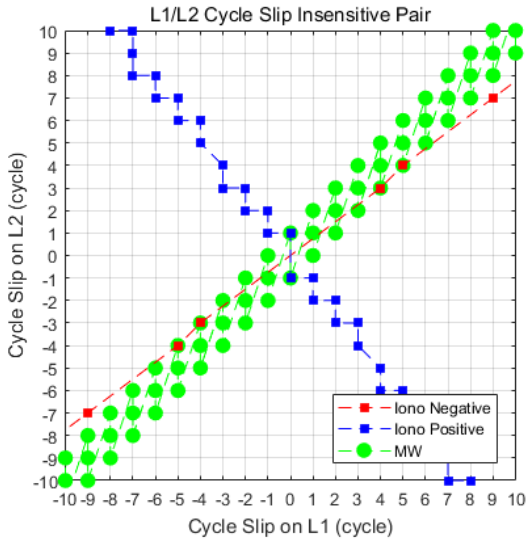
Figure 6. L1/L2 insensitive cycle-slip pairs; the red square points represent the insensitive pairs of the IN combination, the blue square points represent that of the IP combination, and the green circle points represent that of the MW combination.